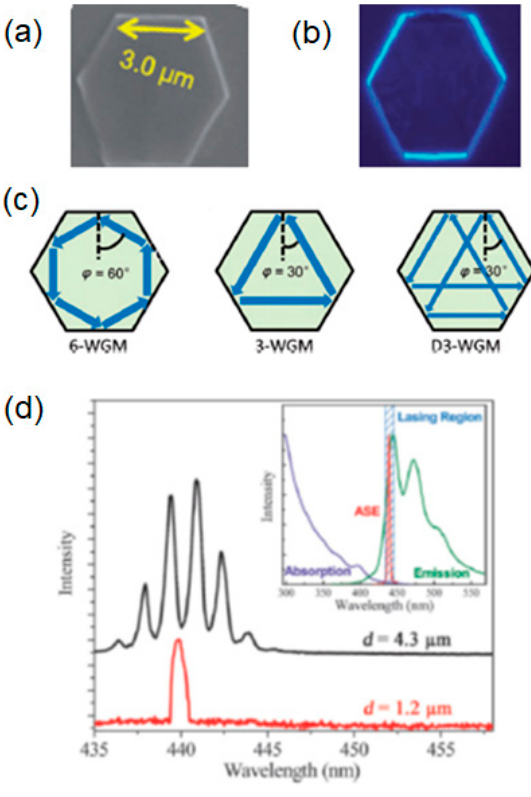
Figure 14. ( a ) Scanning electron microscope image of a DSB hexagonal disk and ( b ) corresponding fluorescence image. The alternate bright edges support the existence of only three reflecting edges. ( c ) Possible geometric resonances that the disk can support. ( d ) Multimode and single mode lasing in disks of 4.3 µm and 1.2 µm perimeter. Reproduced with permission from ref. [126]. Copyright 2014, Wiley-VCH.